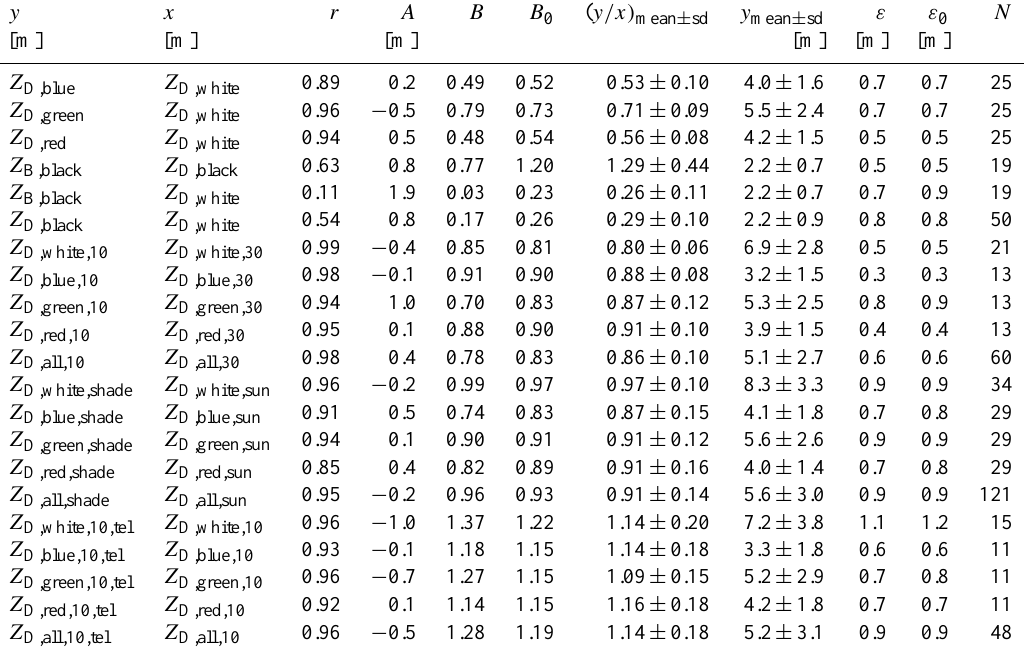
Table 4. Linear relationships of the forms y = A + Bx and y = B 0 x obtained by correlation analysis of Z D (white disk) observed by the open eye and with blue, green and red glass filters, and Z D,black (disk) and Z B,black (bowl) observed by the open eye. Mean values of y/x and y and their standard deviations are included. The size of the disk is 30cm if not otherwise indicated. r is the correlation coefficient, ε is the root-mean-square error of the deviations ( y – A – Bx ), and ε 0 is the rms of ( y – B 0 x) . N is the number of data pairs ( y , x)